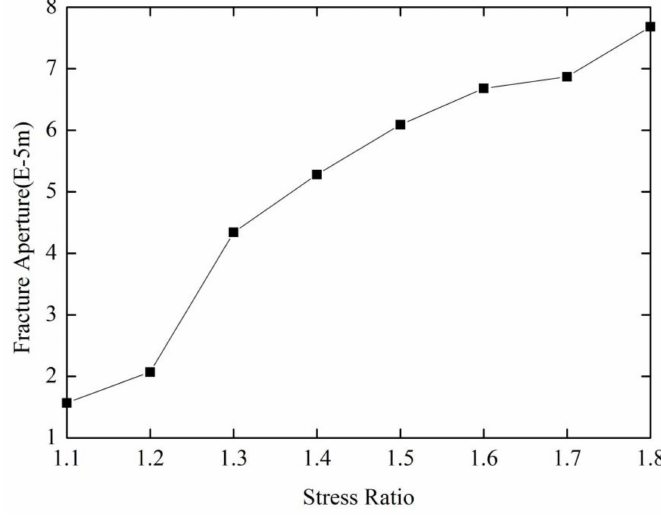
Figure 7. The relationship between maximum aperture and stress ratio.